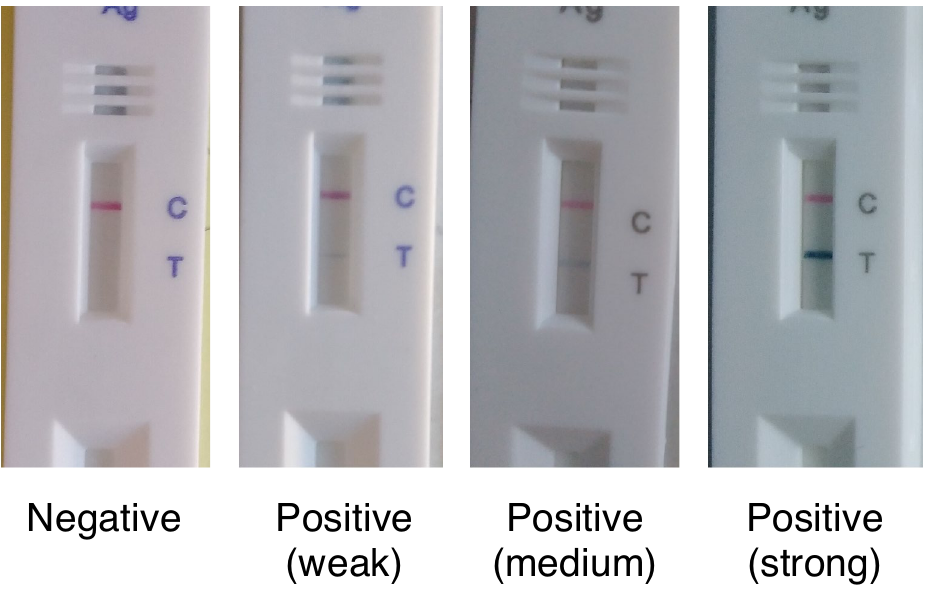
Figure 2. Examples of images of CareStart rapid test showing variable band intensities.